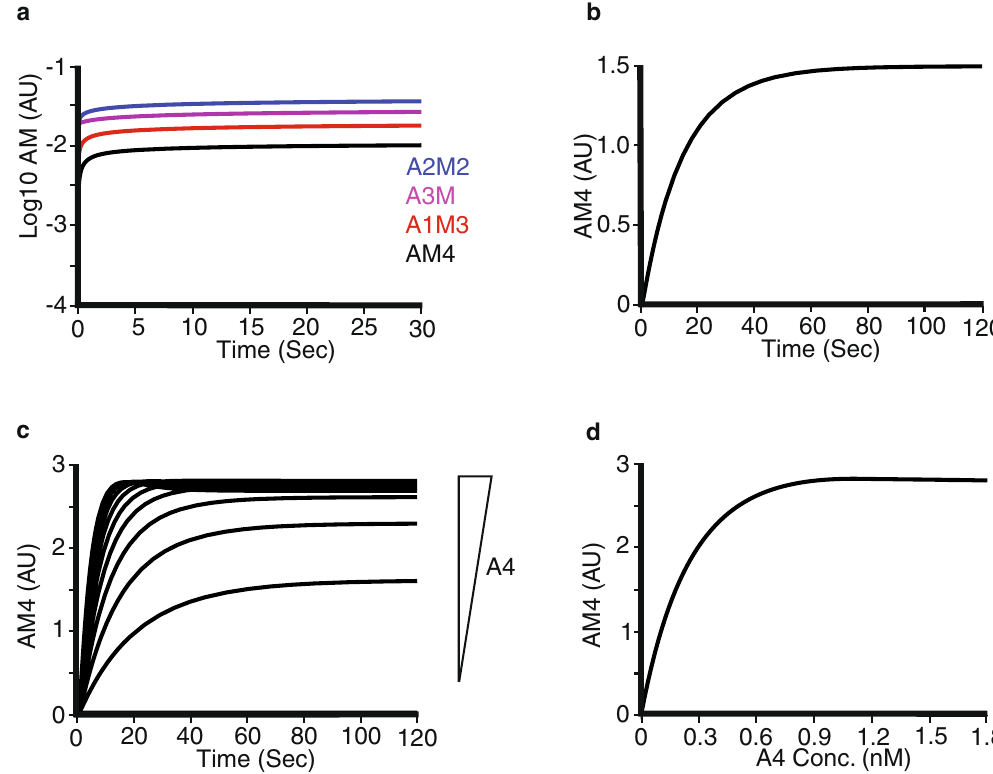
Figure 2. Numerical simulations of Ang1 binding to cellular Tie2. The mathematical model described in Supplementary Information was utilized to examine the time course of formation of cell surface complexes between 0.18 nM Ang1 and cellular Tie2. ( a ) Time course of formation of Ang1 bound to one (A3M; purple), two (A2M2; blue), three (A1M3; red) and four (AM4; black) surface receptors. Amount of complex is shown in log scale (arbitrary units). ( b ) Time course of the formation of Ang1 fully complexed with four cell surface receptors (AM4). ( c ) Time course of formation of AM4 at different Ang1 concentrations up to 1.8 nM. Increasing Ang1 concentration is indicated as an inverted triangle. ( d ) Dependence of AM4 formation on Ang1 (A4)